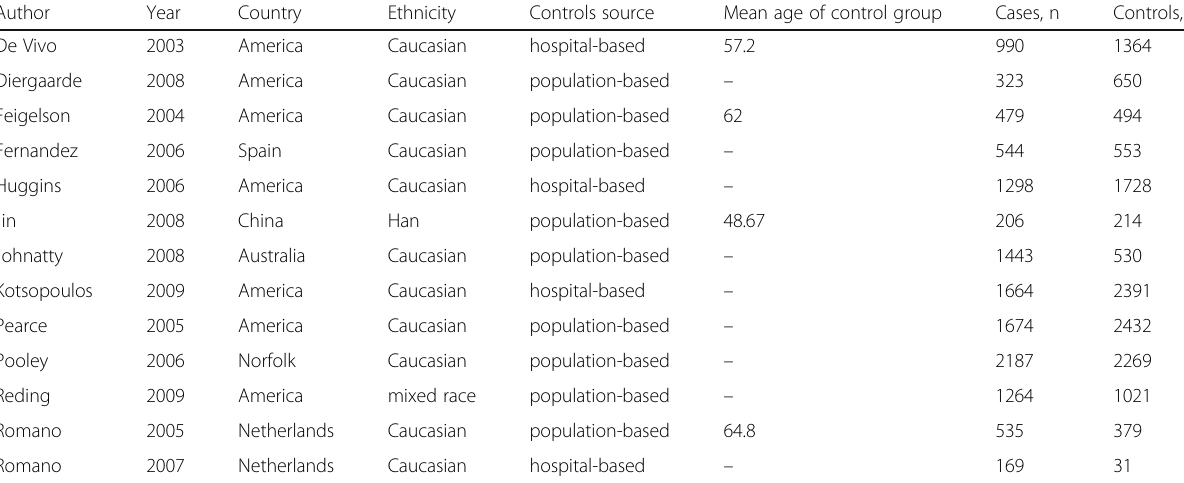
Table 1 Baseline characteristics of qualified studies in this meta-analysis